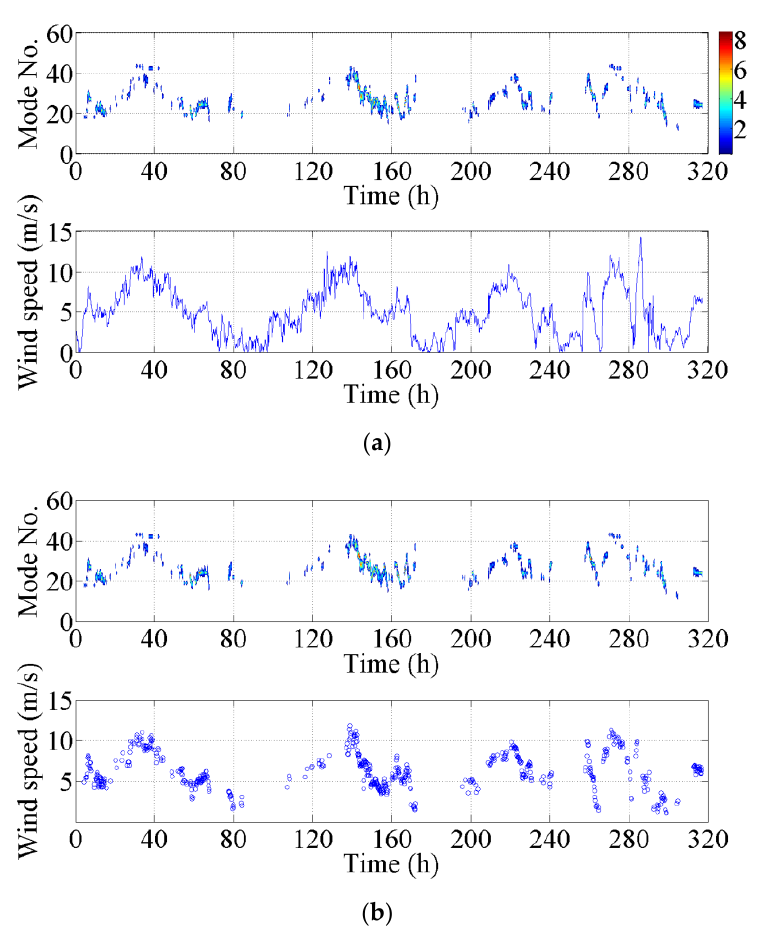
Figure 16. Change of measured vibration modes and mean velosities with time. ( a ) Change of measured vibration modes versus mean velocities; ( b ) Change of measured vibration modes versus mean velocities with the small components being